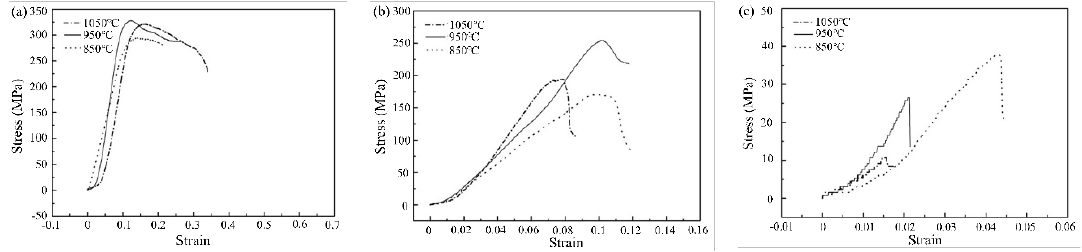
Figure 10. Stress–strain curves of ( a ) T2N8, ( b ) T5N5, and ( c ) T8N2 sintered at various temperatures under compressive tests.